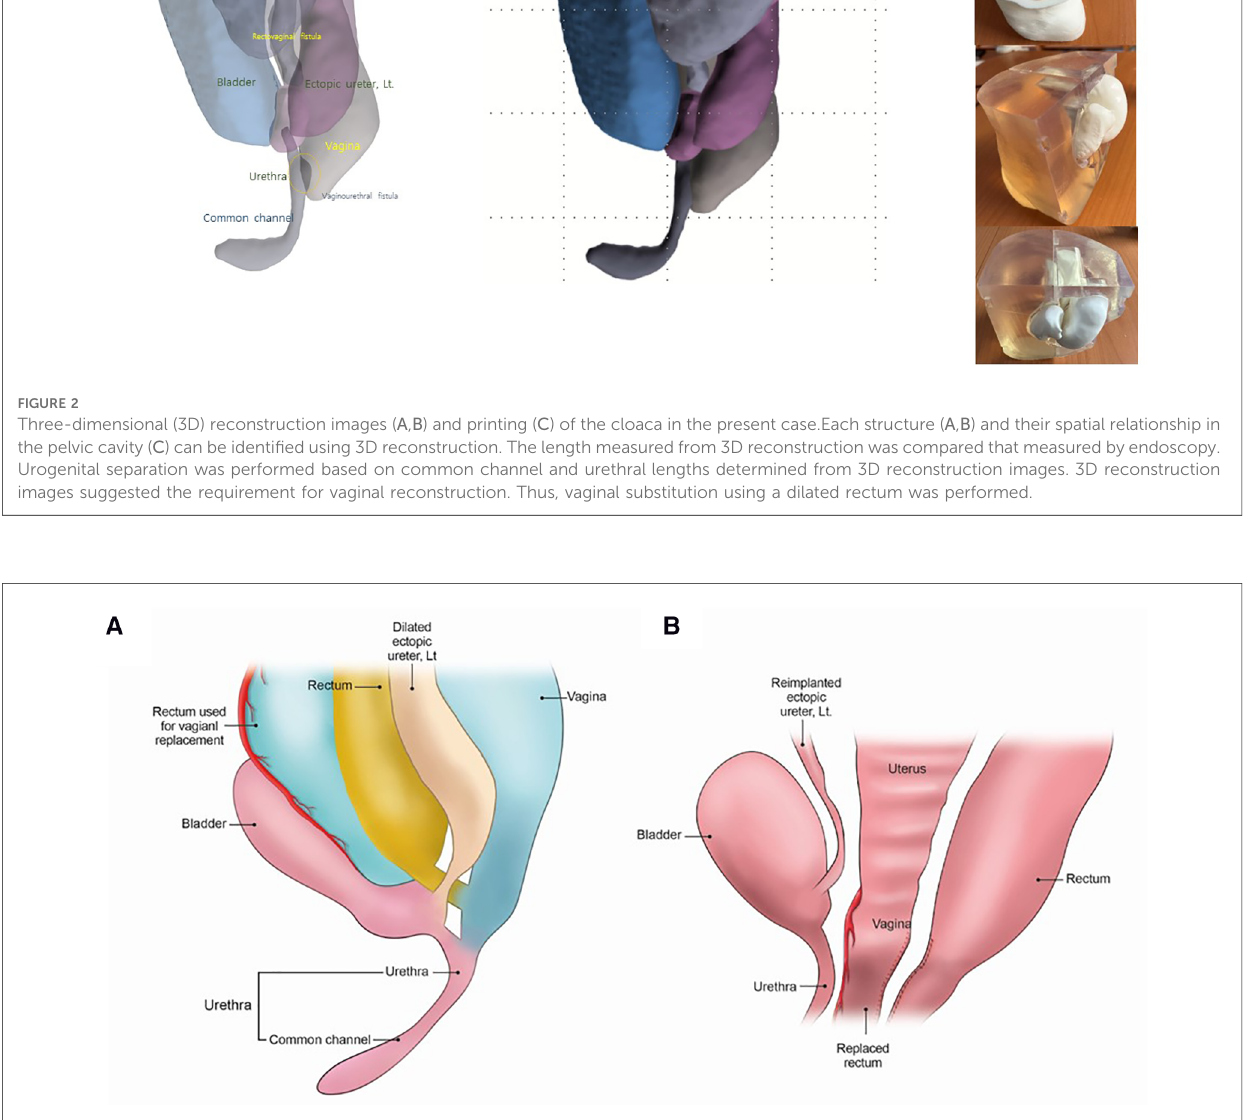
FIGURE 3 Selection of laparoscopic-assisted US with vaginal replacement as the most appropriate surgical approach. Mobilization was performed via a laparoscopic approach. Urogenital separation (US) was performed due to the presence of a short urethra (9 mm in length). Vaginal replacement was performed using a dilated rectum after distal resection of the vagina as it was extremely dif fi cult to fully pull through the dilated vagina. ( A ) Before operation ( B ) Post-operative